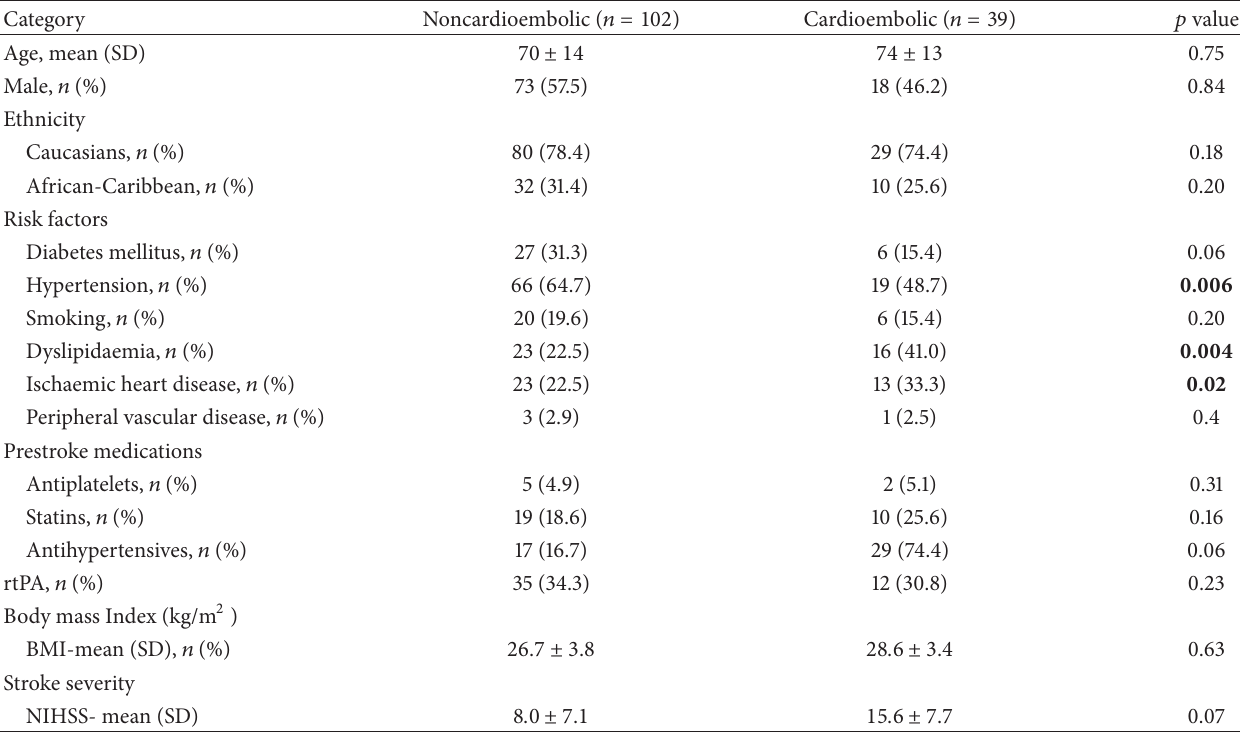
Table 2: Baseline characteristics in ischaemic stroke subgroup.